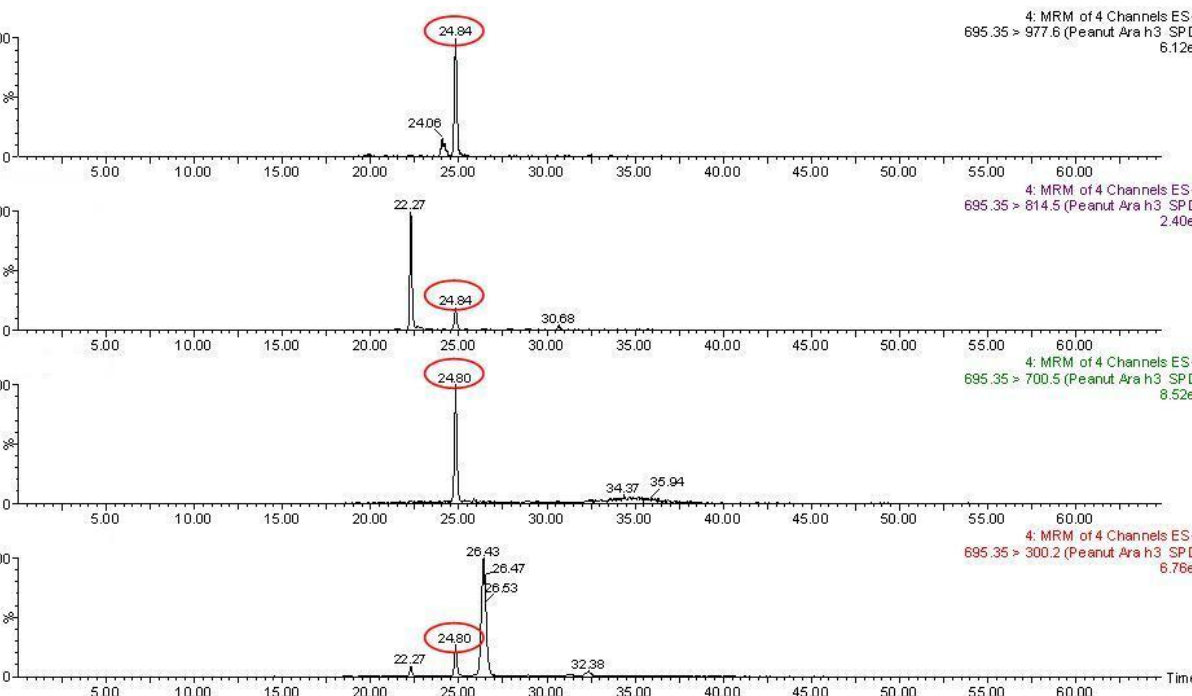
Figure 4. Selective Reaction Monitoring (SRM) of the Ara h 3 peptide SPDIYNPQAGSLK ( m/z 695.4, 2+) in enriched cookie samples incurred with 10 μ g peanuts g − 1 matrix. SRM analysis was carried out on a Waters Quatro Premier triple